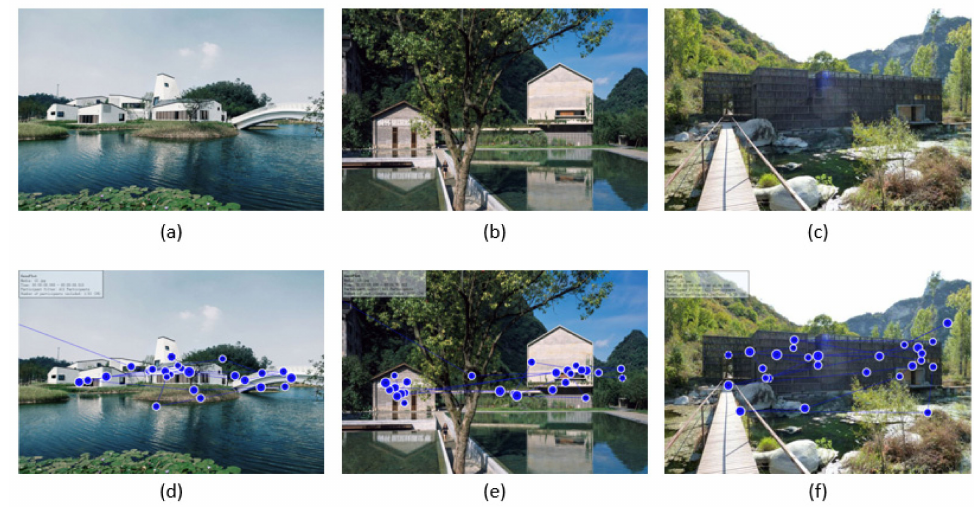
Figure 7. Fixation trajectories of the first group of experiments: ( a ) Sample 1; ( b ) Sample 2; ( c ) Sample